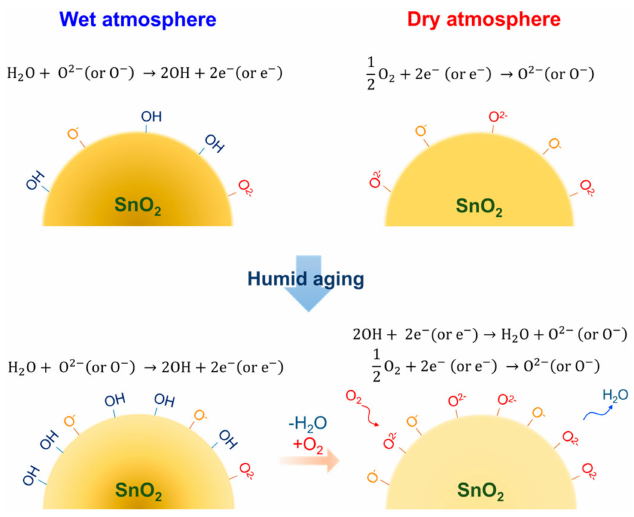
Figure 5. Schematic model of the effect of humid aging for oxygen adsorption on the SnO 2 surface in dry and wet atmospheres.